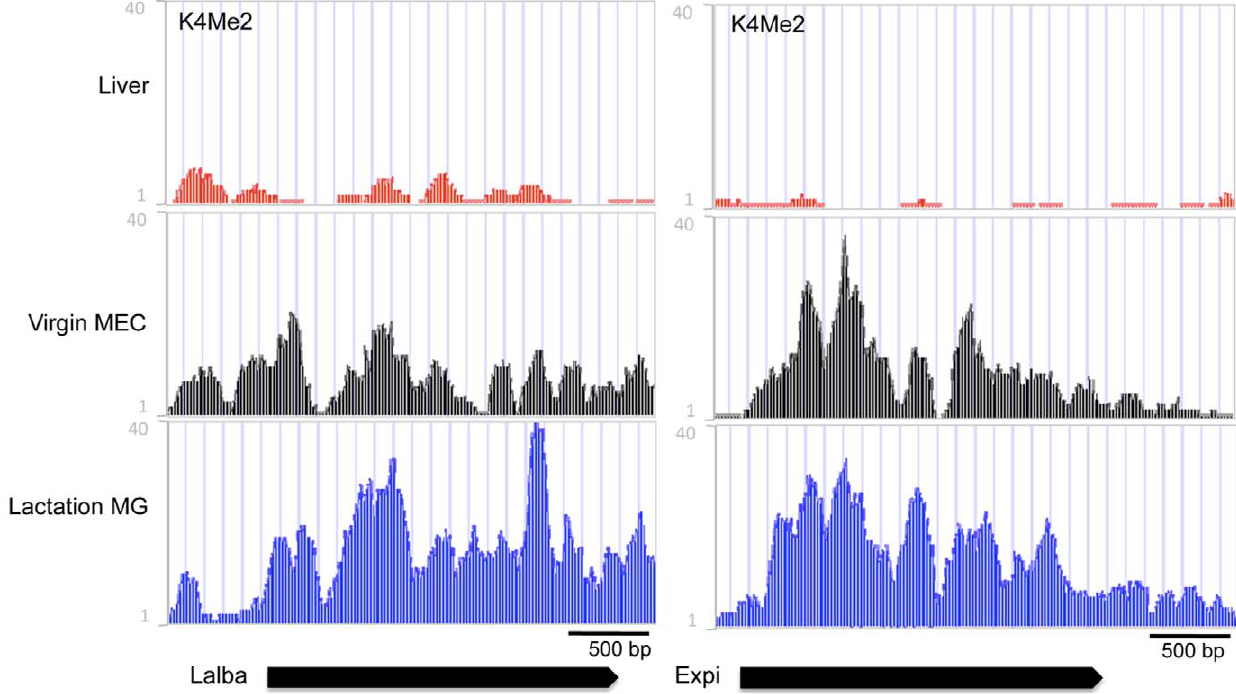
Figure 4. Alpha-lactalbumin (Lalba) and extracellular proteinase inhibitor (Expi) developmental chromatin organization. ChIP-seq reads for H3K4me2 in liver tissue ( Liver , red), mammary epithelial cells isolated from 12 week virgin mammary glands ( Virgin MEC , black), and lactating mammary glands ( Lactating MG , blue). In the bottom panel, black arrows indicate location and transcriptional direction of the Lalba and Expi